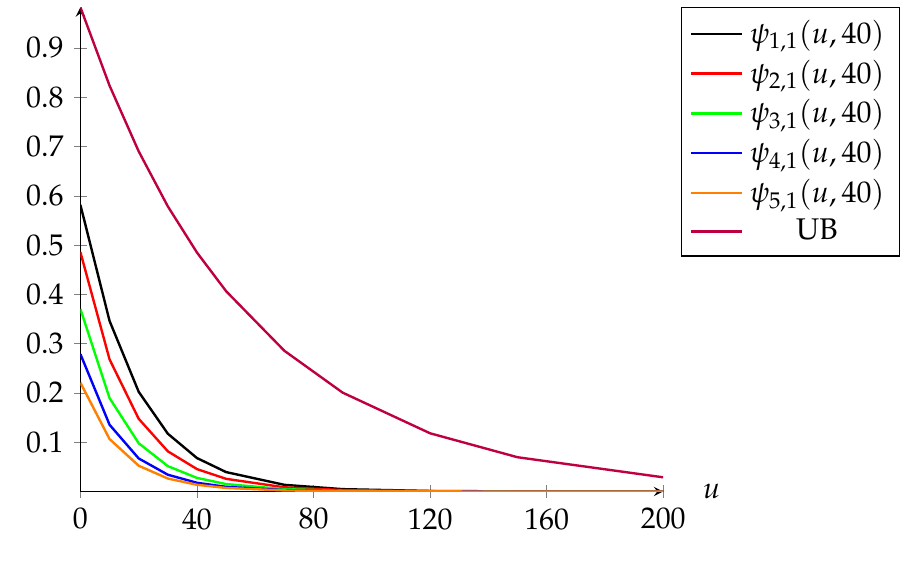
Figure 2. ψ i ,1 ( u ,40 ) with the upper bounds.